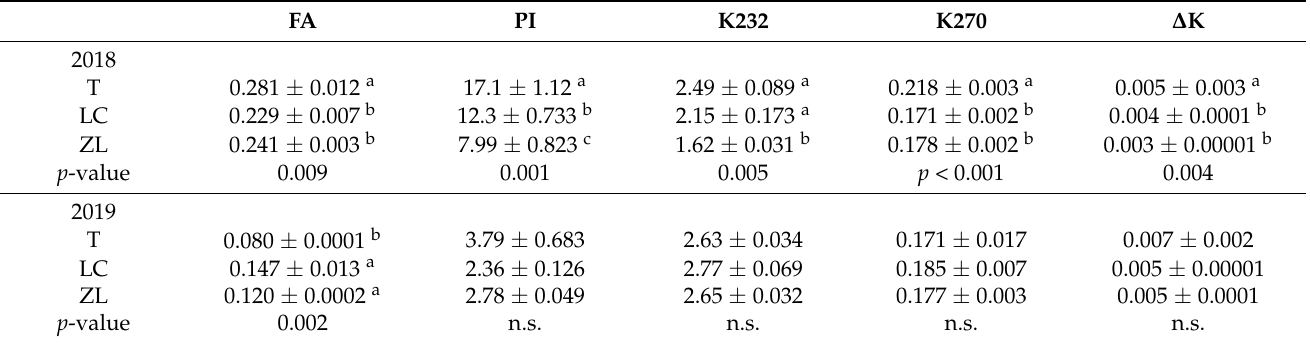
Table 8. Olive oil quality indices as a function of soil management treatments and harvest year.